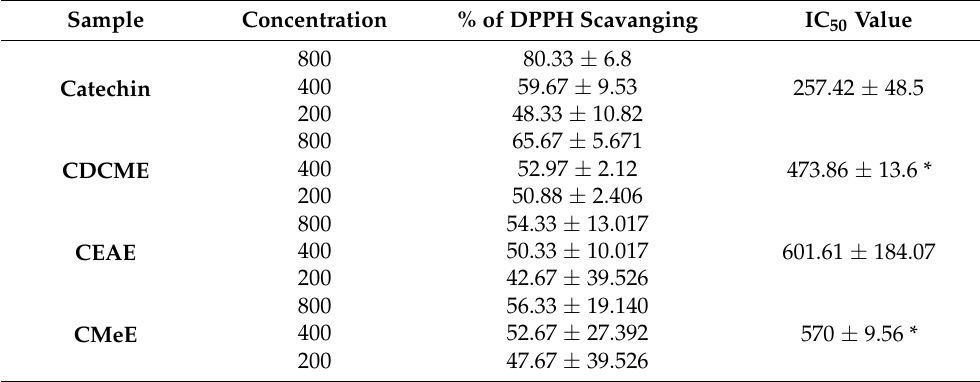
Table 2. Antioxidant activity of the extracts of Oldenlandia corymbosa L. by DPPH scavenging assay.